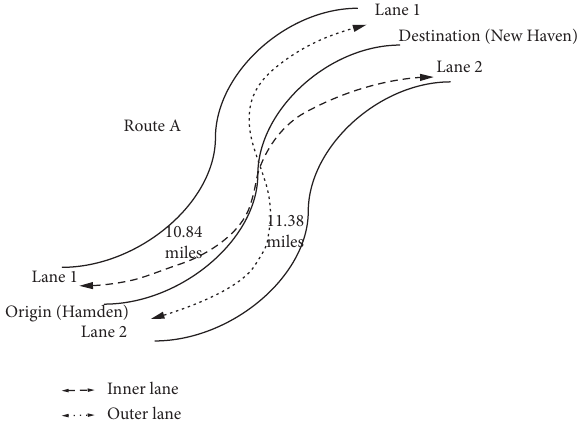
Figure 1: An illustration of